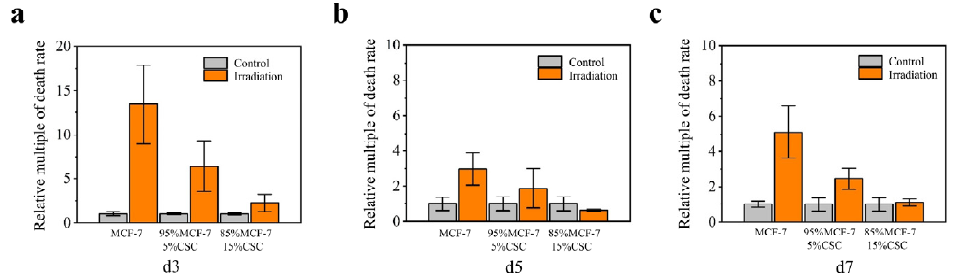
Figure 5. Differences in death rates between control and irradiated tumor spheroids cocultured with MCF-7 cells and CSCs at different ratios. ( a ) Day 3 after irradiation, ( b ) day 5 after irradiation, ( c ) day 7 after irradiation.